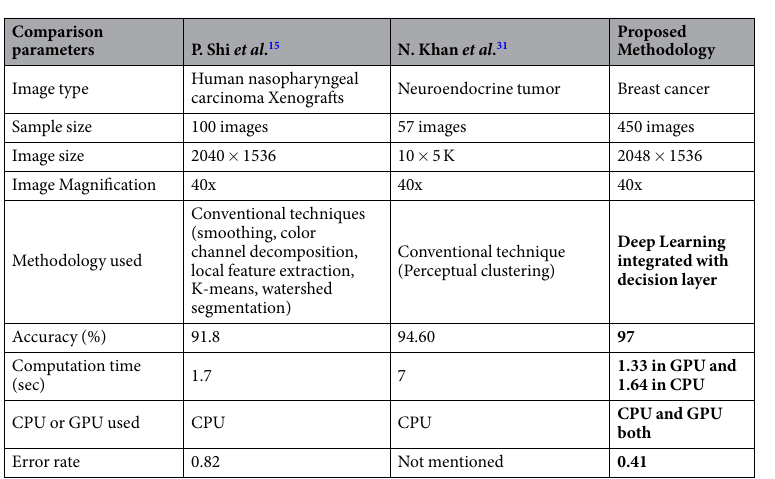
Figure 9. Overall detection of hotspots in breast cancer IHC images at different proliferation levels.